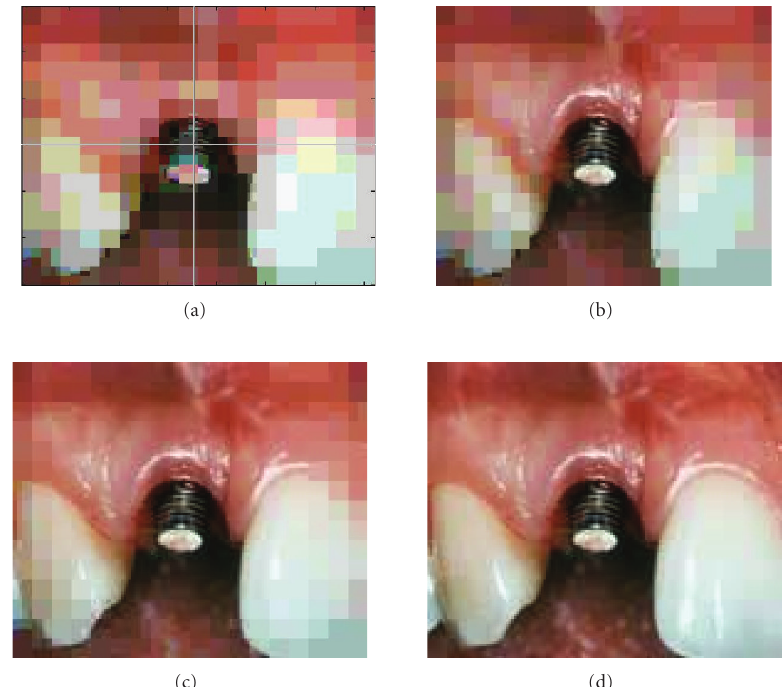
Figure 9: The transmitted image over the low noise: (a) the background image at stage P 1 and the location of RoI in the center of the image, (b) the transmitted image after stage P 2 , (c) the transmitted image after stage P 3 , and (d) shows the completely decoded image after stage P 4 .